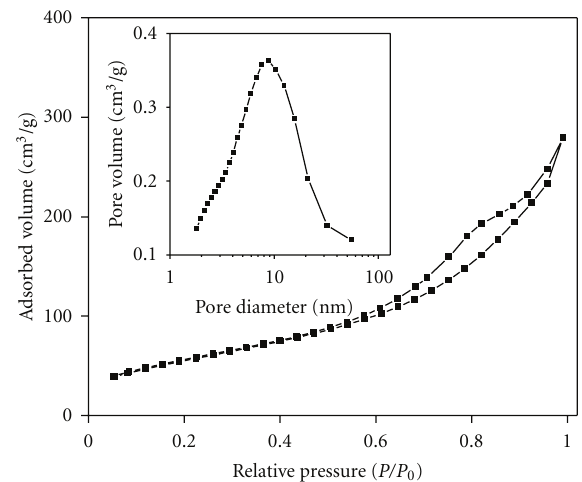
Figure 5: N 2 adsorption-desorption isotherm and pore size distri- bution curve (inset) of the R Au -0.015 composite